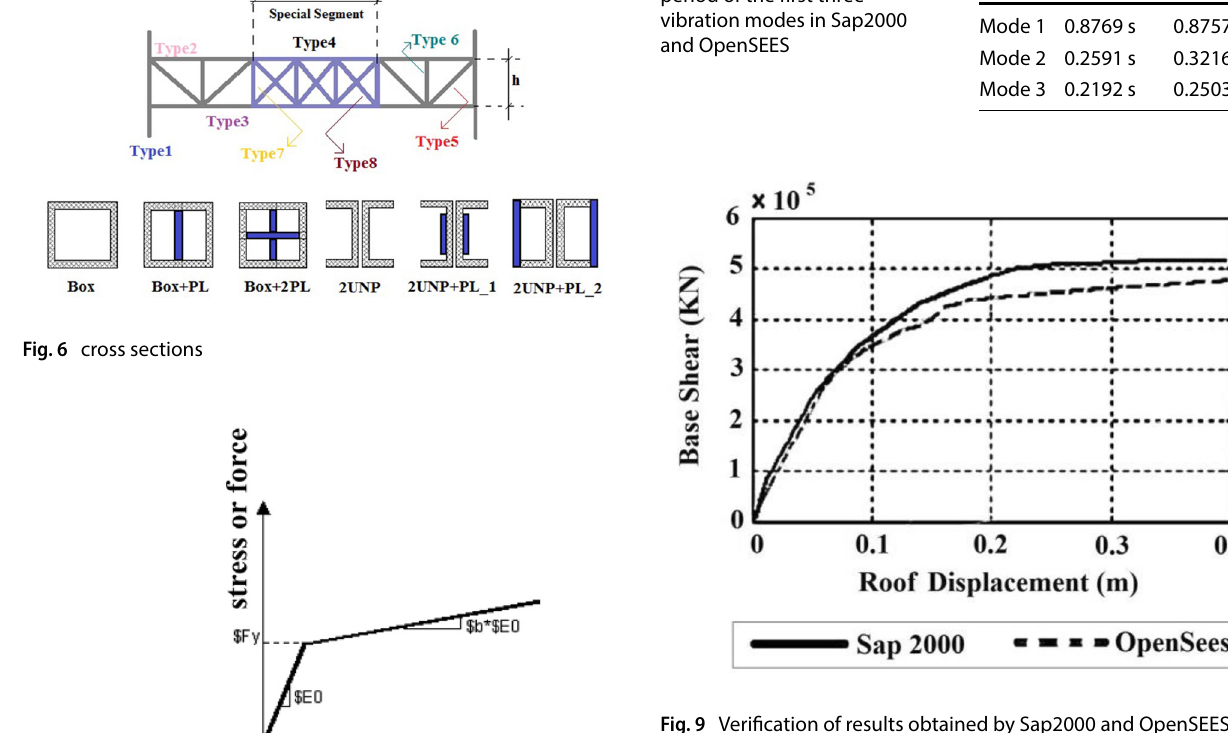
Fig. 9 Verification of results obtained by Sap2000 and